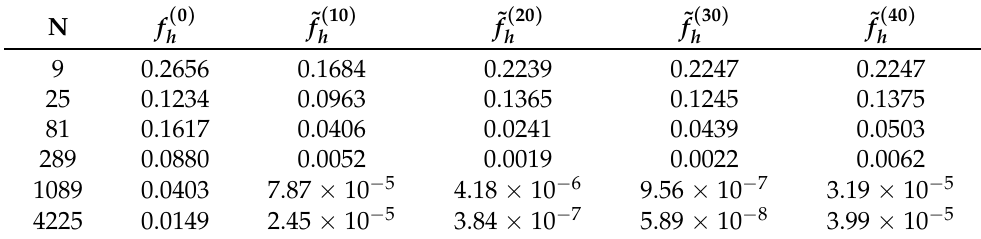
Table 4. RMSEs for the E-ISPH, f